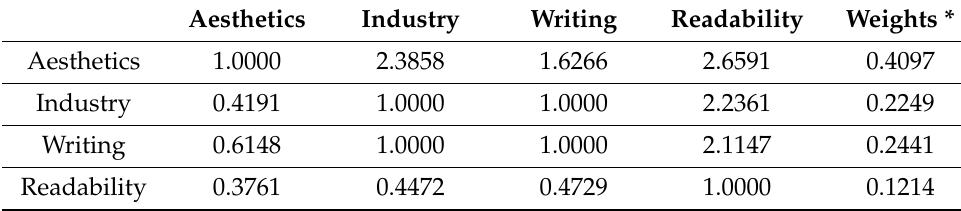
Table 4. The pairwise comparison matrix and weights within the Profession dimension.